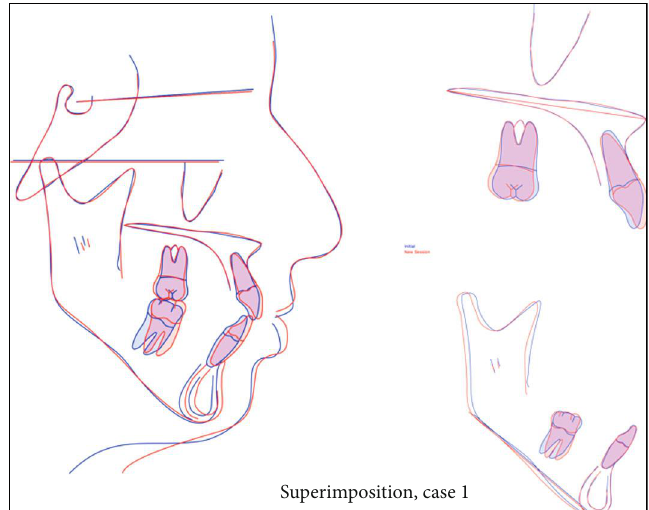
Figure 7: Superimposition.